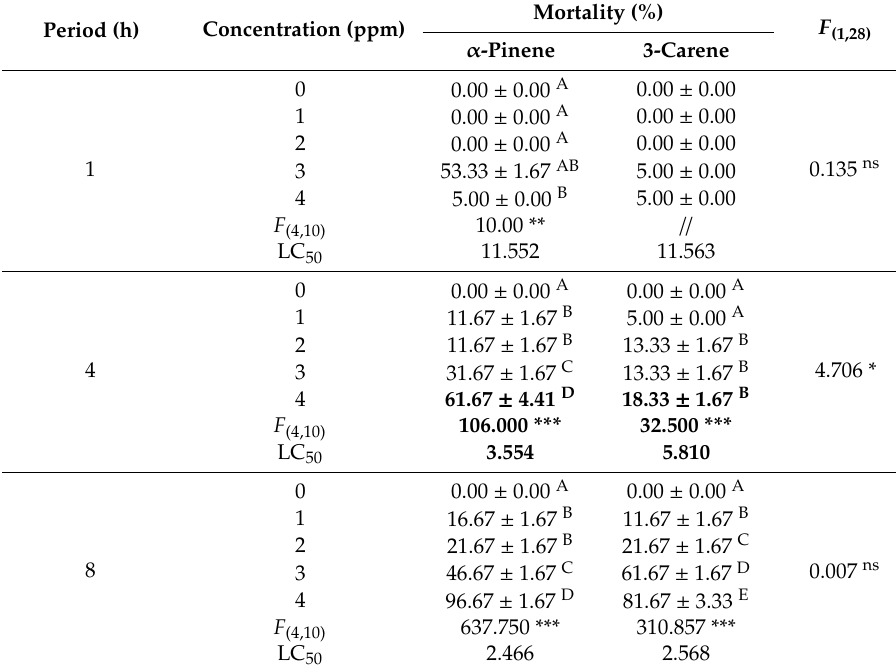
Table 3. Mortality of Sitophilus zeamais due to exposure to α -pinene and 3-carene fumes.